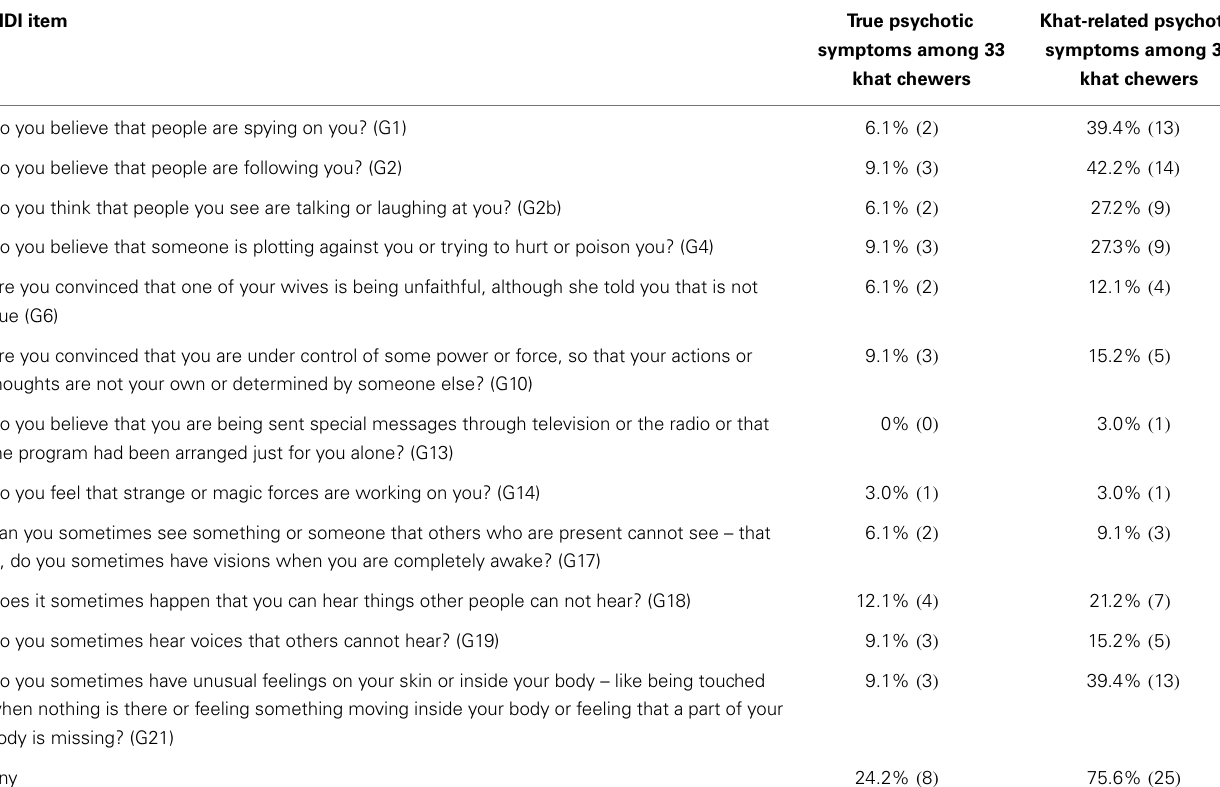
Table 5 | Psychotic symptoms among khat chewers